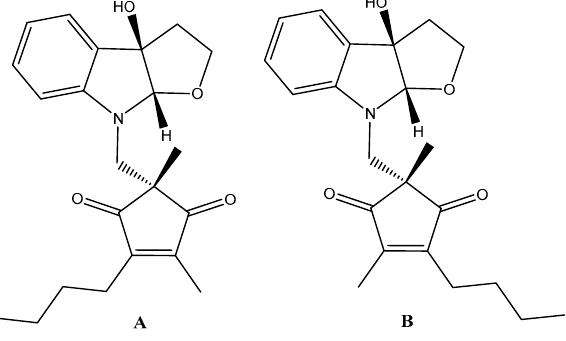
Figure 6. Madindoline regioisomers ( A ) and ( B ).